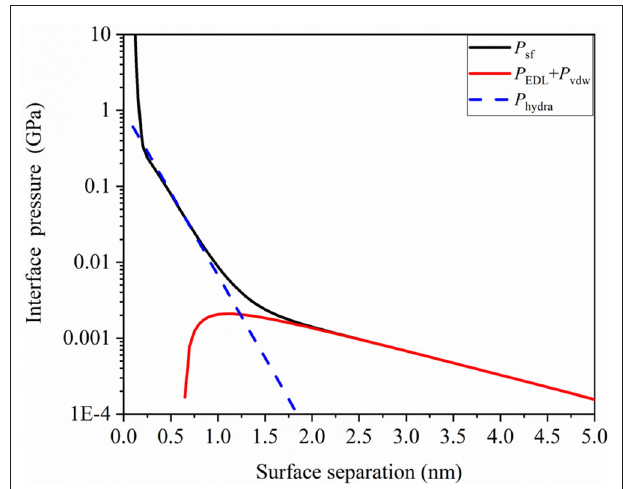
FIGURE 4 | Interface pressure due to surface force as a function of surface separation in confined aqueous